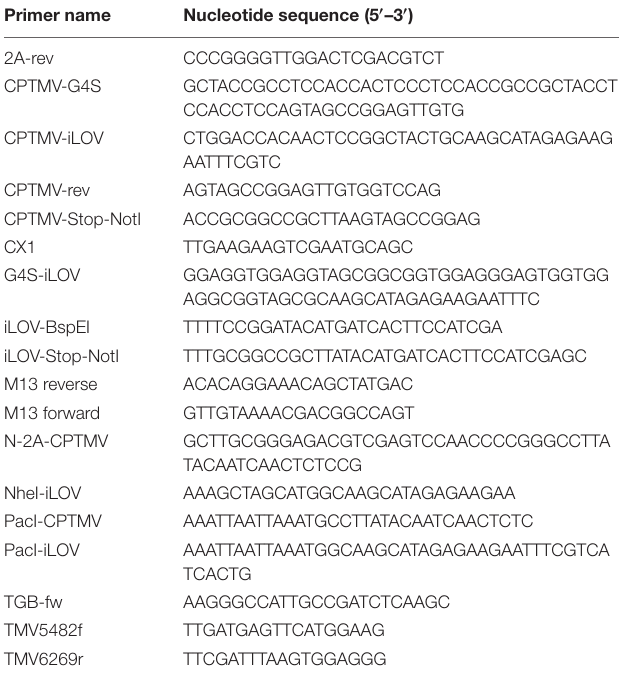
TABLE 1 | Oligonucleotides used for PCR. Primer